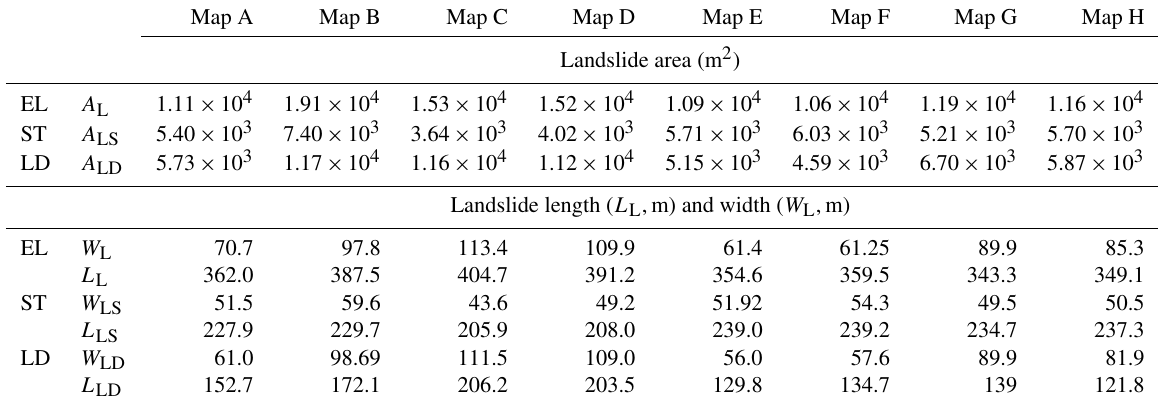
Table 2. Comparison of the total landslide area ( A L ) , the landslide source and transportation area ( A LS ) , the landslide deposit ( A LD ) , the width and length of the entire landslide ( W L , L L ) , of the source and transportation area ( W LS , L LS ) , and of the deposit ( W LD , L LD ) , for eight separate and independent cartographic representations of the Assignano landslide. EL, entire landslide; ST, landslide source and transport area; LD, landslide deposit. See Table 3 for the characteristics of the single maps. Map A Map B Map C Map D Map E Map F Map G Map H Landslide area (m 2